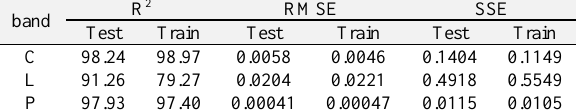
Table 9. Results of SVR model with optimal features selection with SBS algorithm with optimizing SVR